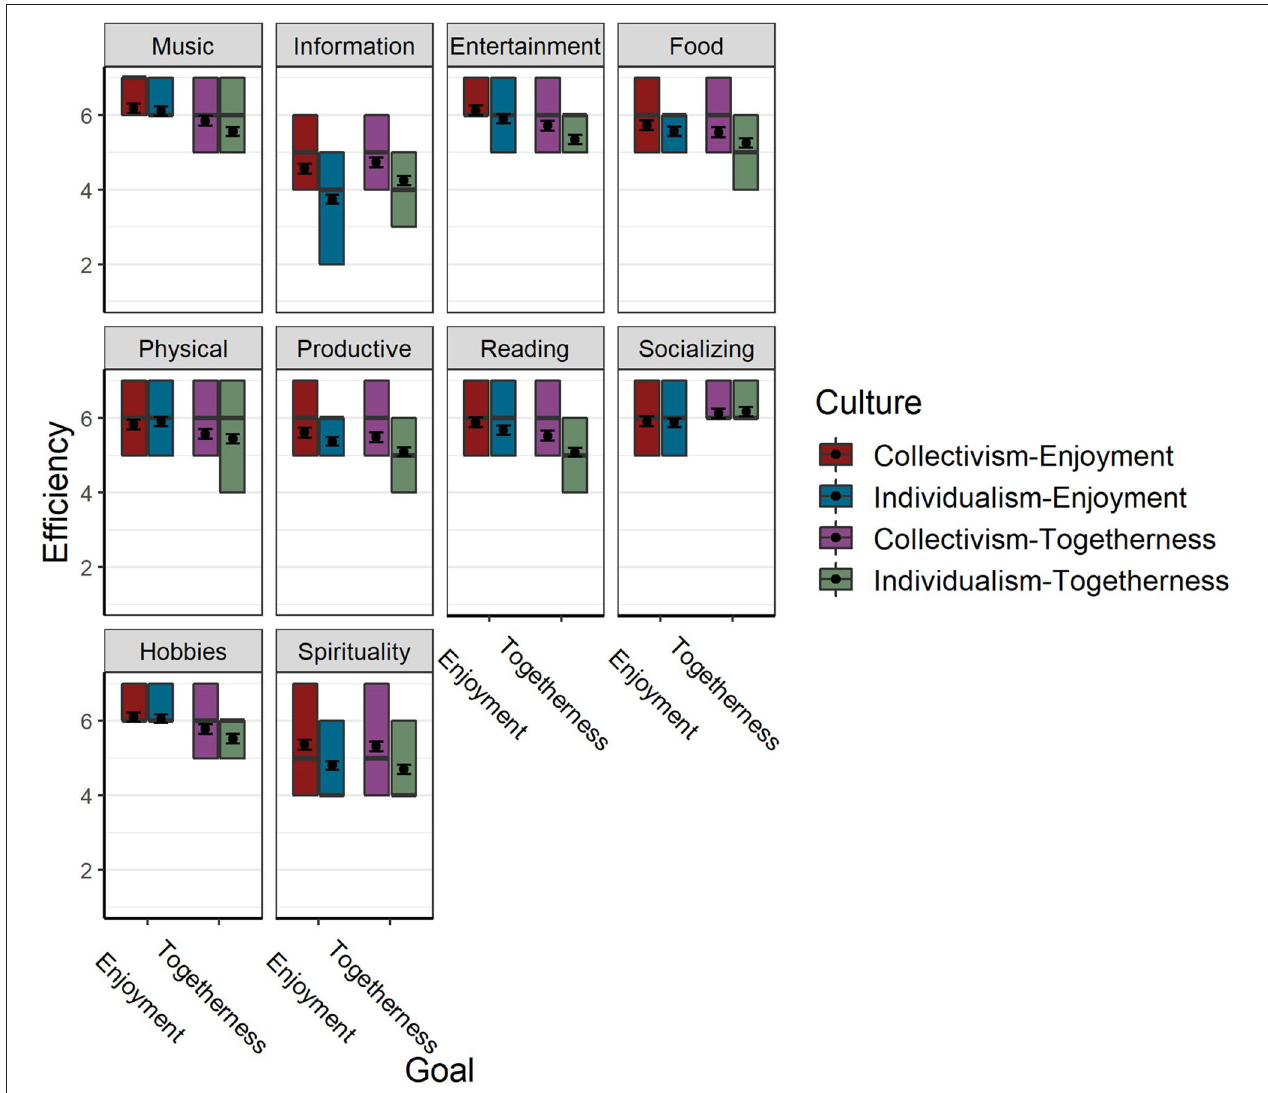
FIGURE 3 | Efficiency of Activities in obtaining “Enjoyment and maintaining good mood” and “Reducing Loneliness and Creating a Sense of Togetherness” by culture. Colored squares represent the 2nd and 3rd quartiles of responses. Black lines represent the median, and “x” represents the